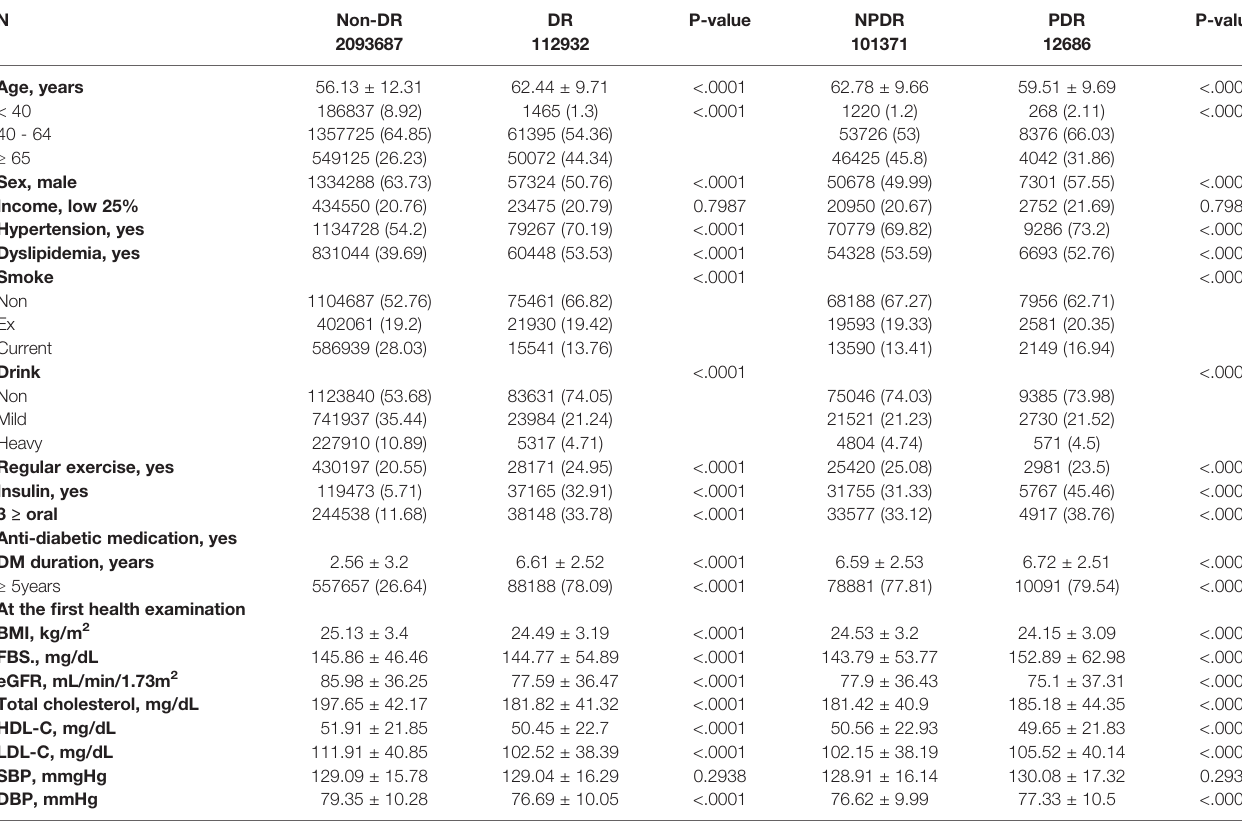
TABLE 1 | Baseline characteristics of the study